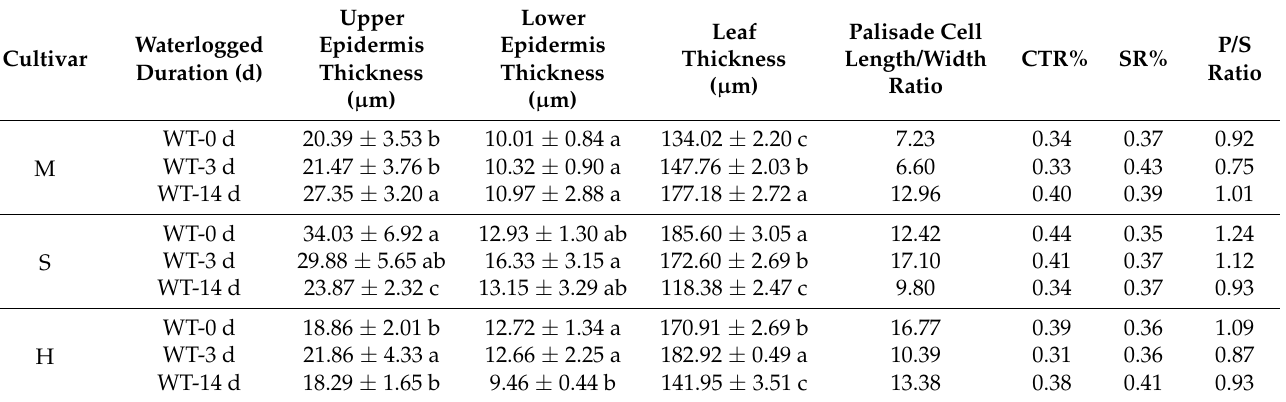
Table 3. Comparison of leaf anatomical characteristics of different peach rootstock seedlings under waterlogging